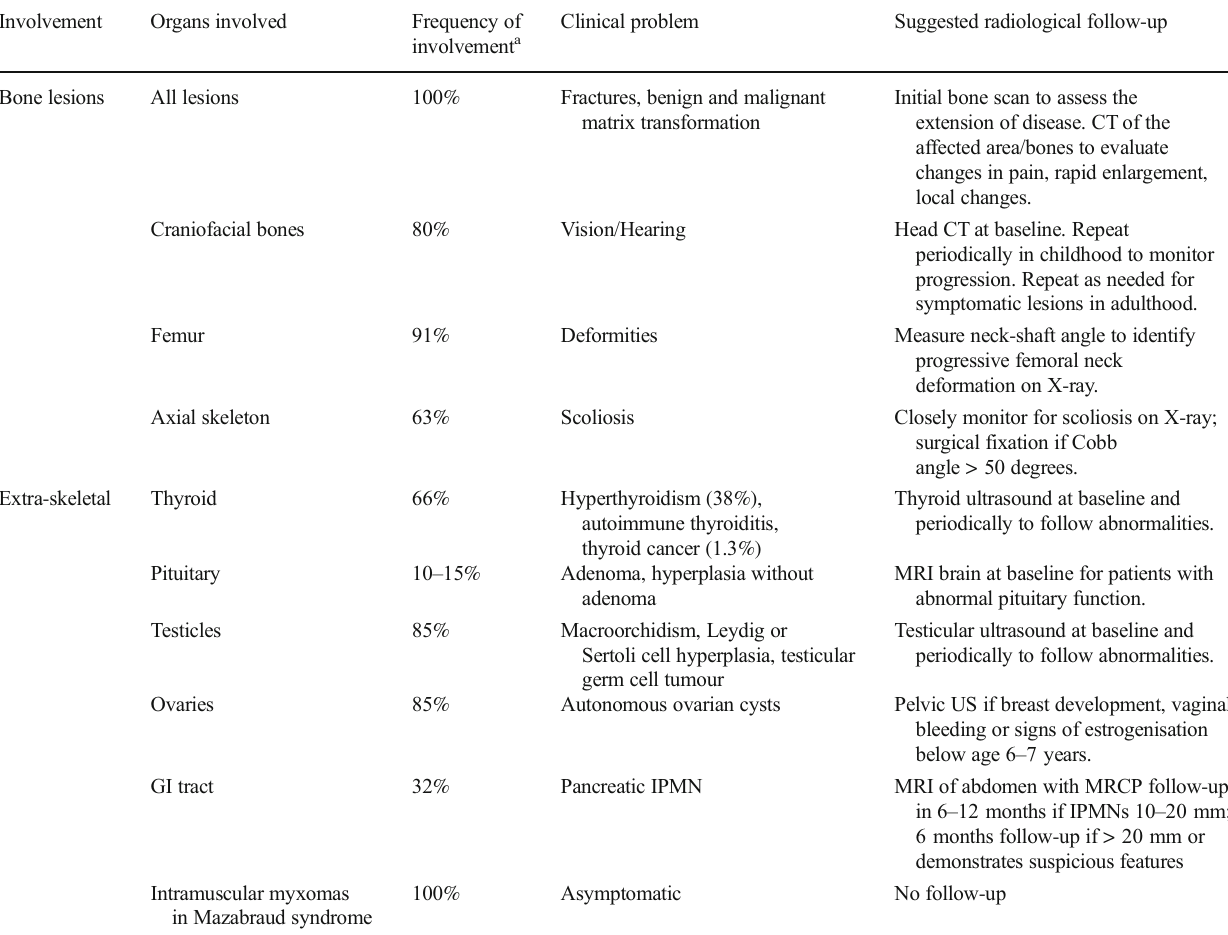
Suggested follow-up imaging for patients with fibrous dysplasia, McCune-Albright syndrome and Mazabraud syndrome (an expert opinion, based on the NIH cohort) Involvement Organs involved Clinical